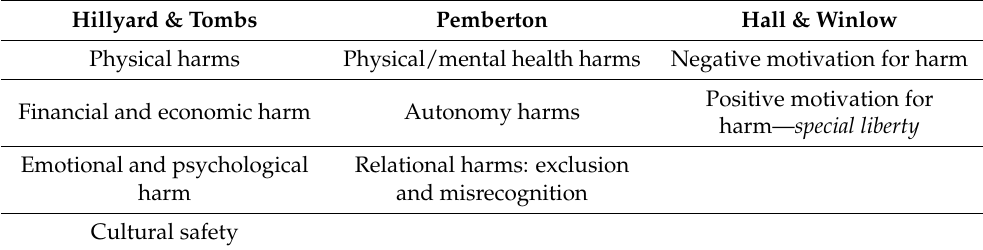
Table 1. Classifications of social